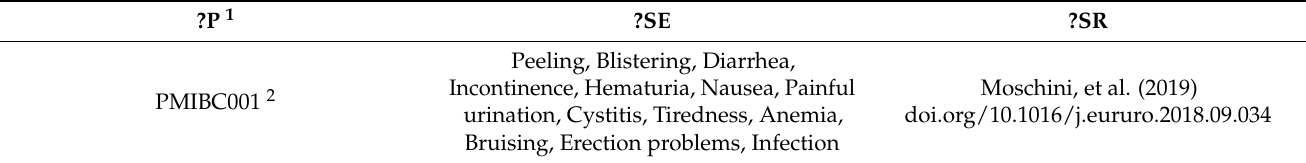
Table 4. SQWRL side effects’ results and their related standard reference.